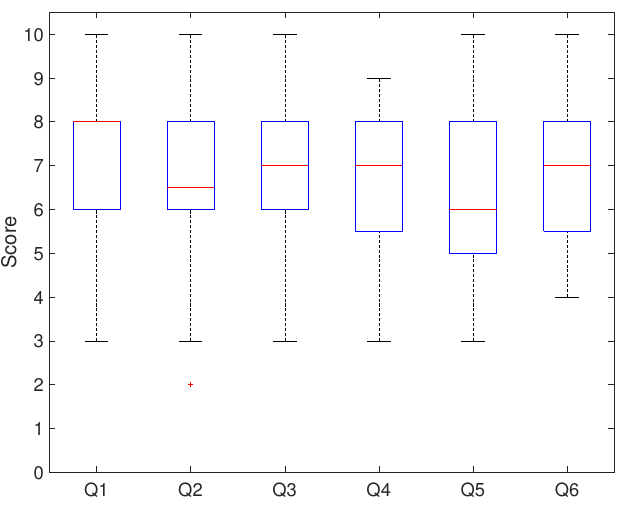
Figure 10. Points of each questionnaire